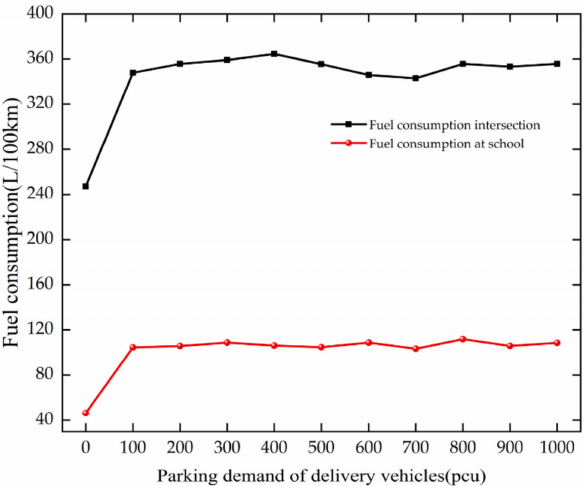
Figure 17. Variation trend of fuel consumption with